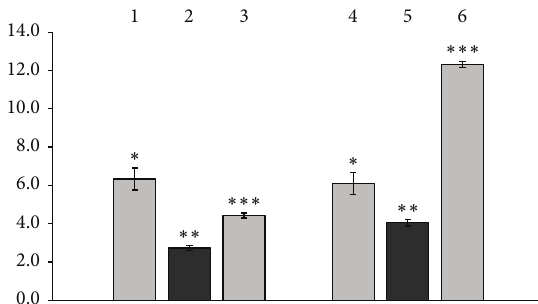
Figure 1: Production of GM-CSF by normal human PBC induced with human serum 𝛾 -globulin metal complexes formed with copper or zinc ions, with control 𝛾 -globulins, and with copper and zinc ions used alone (𝑀 ± 𝑚, 𝑛 = 4) . Induction for 48 hrs at 37 ∘ C. In the ordinate axis: concentration of GM-CSF, pg/ml. Here and at Figures 2 and 3: 1—control 𝛾 -globulin for the zinc complex, 2— 𝛾 -globulin complex formed with zinc ions, 3—zinc ions used alone, 4—control 𝛾 -globulin for the copper complex, 5— 𝛾 -globulin complex formed with copper ions, and 6—copper ions used alone. Here and at the Figures 2 and 3: the concentrations were calculated from the data obtained with using primary (not diluted) state of the samples. ∗ 𝑃 < 0.05 compared with zinc ions used alone (3) or with 𝛾 - globulincomplexformedwithcopperions(5); ∗∗ 𝑃 < 0.01 compared with control 𝛾 -globulin for the zinc complex (1) or with 𝛾 -globulin complex formed with zinc ions (2); ∗∗∗ 𝑃 < 0.001 compared with 𝛾 - globulin complex formed with zinc ions (2) or with zinc ions used alone (3), with control 𝛾 -globulin for the copper complex (4) and with 𝛾 -globulin complex formed with copper ions